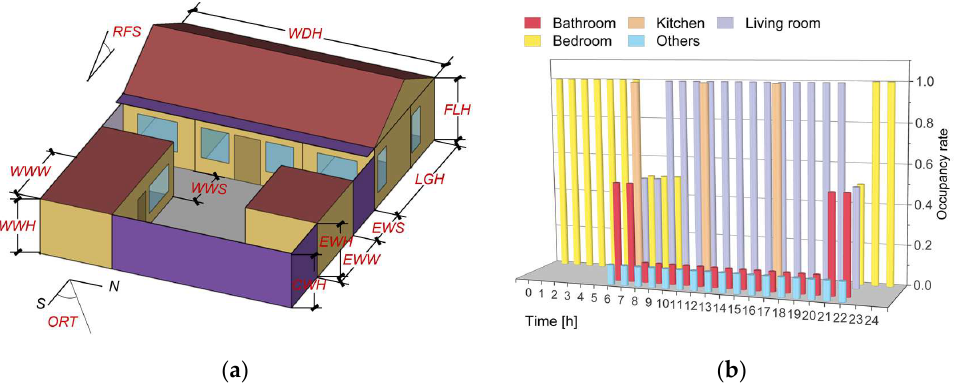
Figure 3. Parametric building energy model with geometric variables and the floor plan of the case: ( a ) parametric BEM; ( b ) occupancy rate. ( a ) parametric BEM; ( b ) occupancy